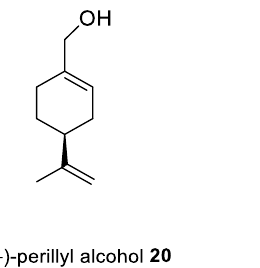
Figure 10. The structural formula of NEO212. A novel agent, NEO412 ( 23 ) (Figure 11) was designed and studied in response to the need for improved transdermal treatment of melanoma. NEO412 ( 23 ) is a compound built by the covalent conjugation of three agents: TMZ, ( − )-POH and linoleic acid. Swenson et al. investigated the anti-melanoma potency of this novel agent in vitro and in mouse mod- els in vivo. The research shows that NEO412 ( 23 ) efficaciously killed melanoma cells in vitro. In vivo, NEO412 inhibited tumor growth when applied to the skin of animals bear- ing tumors (Table 1). This effect included a combination of increased tumor cell death